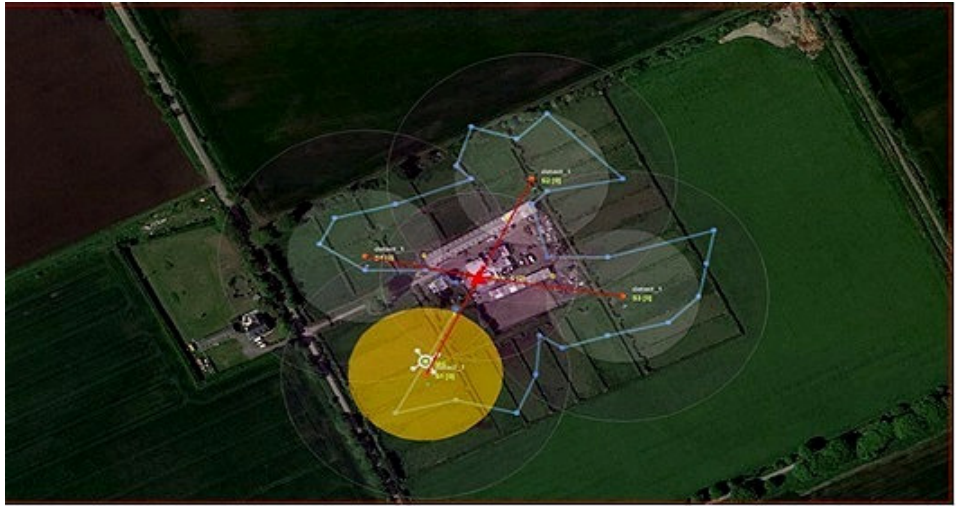
Figure 11. Whenever a pest entered the sensing range of a sensing node, the simulator highlighted it with yellow color.